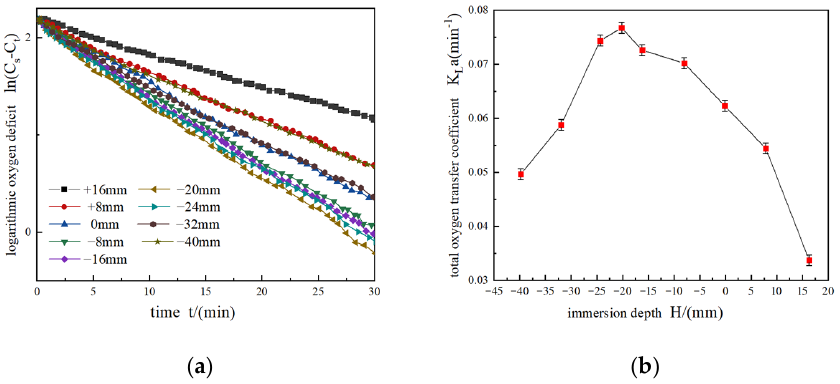
Figure 11. Logarithmic oxygen deficit and total oxygen transfer coefficient at different immersion depths: ( a ) logarithmic oxygen deficit; ( b ) total oxygen transfer coefficient.